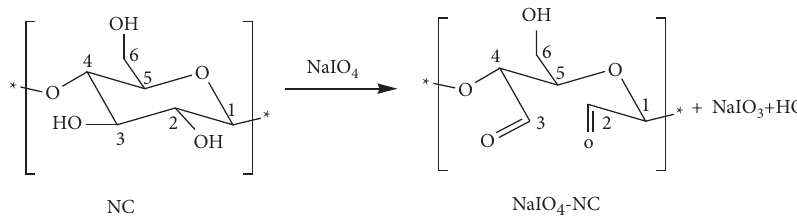
Figure 2: Sodium periodate oxidation of nanocellulose (NC).